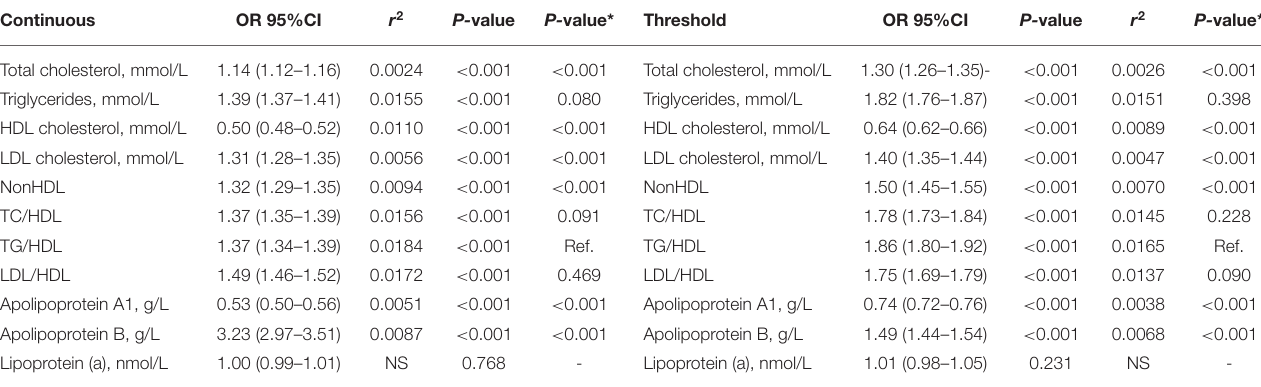
TABLE 4 | Univariate logistic regression models for arterial stiffness (defined as ASI > 10 m/s) with each lipid parameter in continuous values and threshold cutoffs.